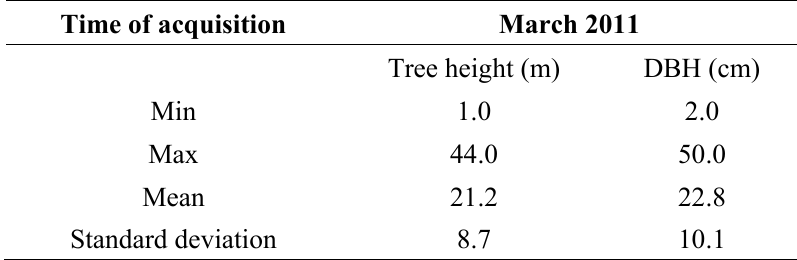
Table 6. Statistical summary of field tree variables in Test Site